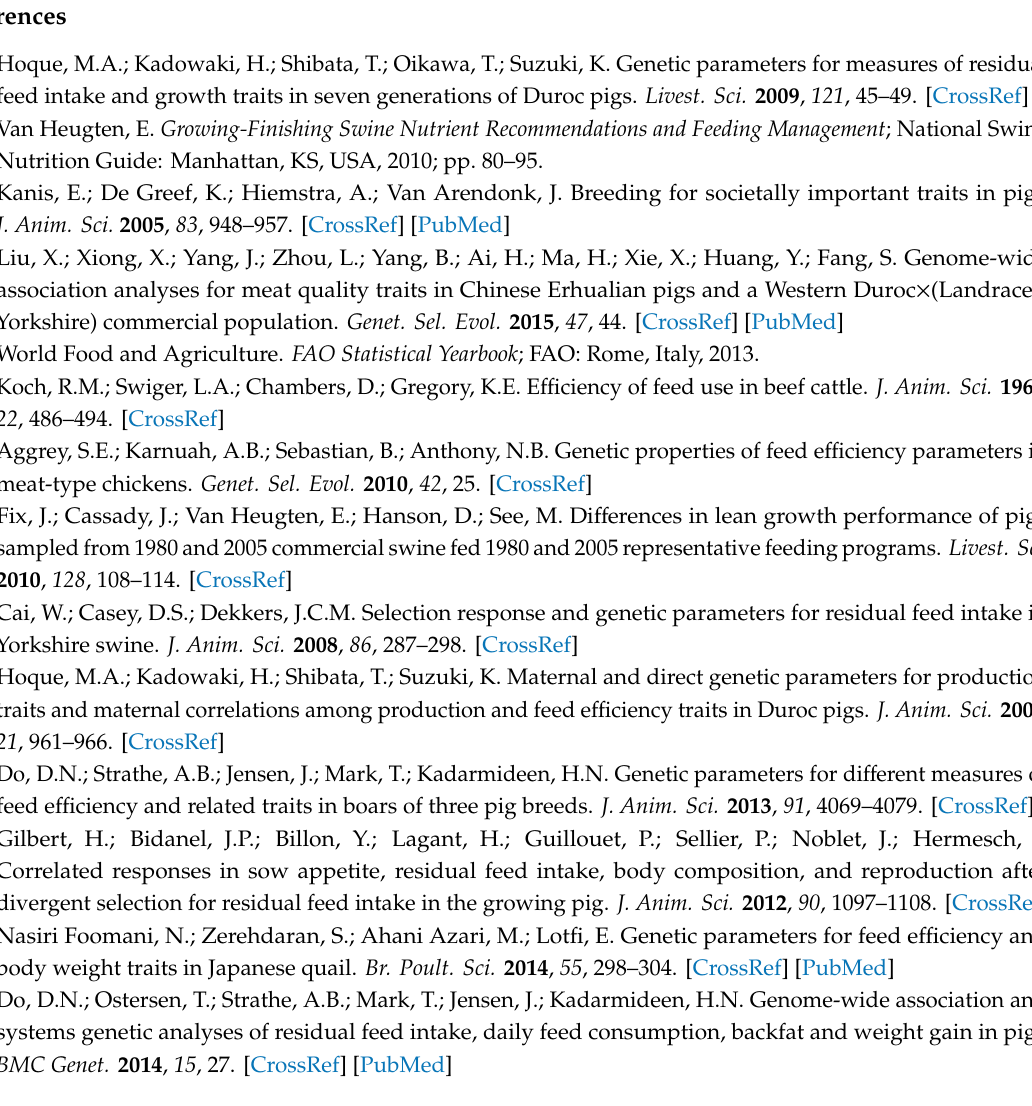
Figure S1: Alignment distribution of the uniquely mapped reads from RNA-seq in pig small intestine tissue, Figure S2: DAGs of the GO enrichment in DEGs, Table S1: Output statistics and annotation information of sequencing reads, Table S2: all DEGs, Table S3: Gene ontology enrichment result, Table S4: KEGG enrichment result, Table S5: ReactomePA pathway enrichment result, Table S6: Primers for quantitative real time polymerase chain reaction